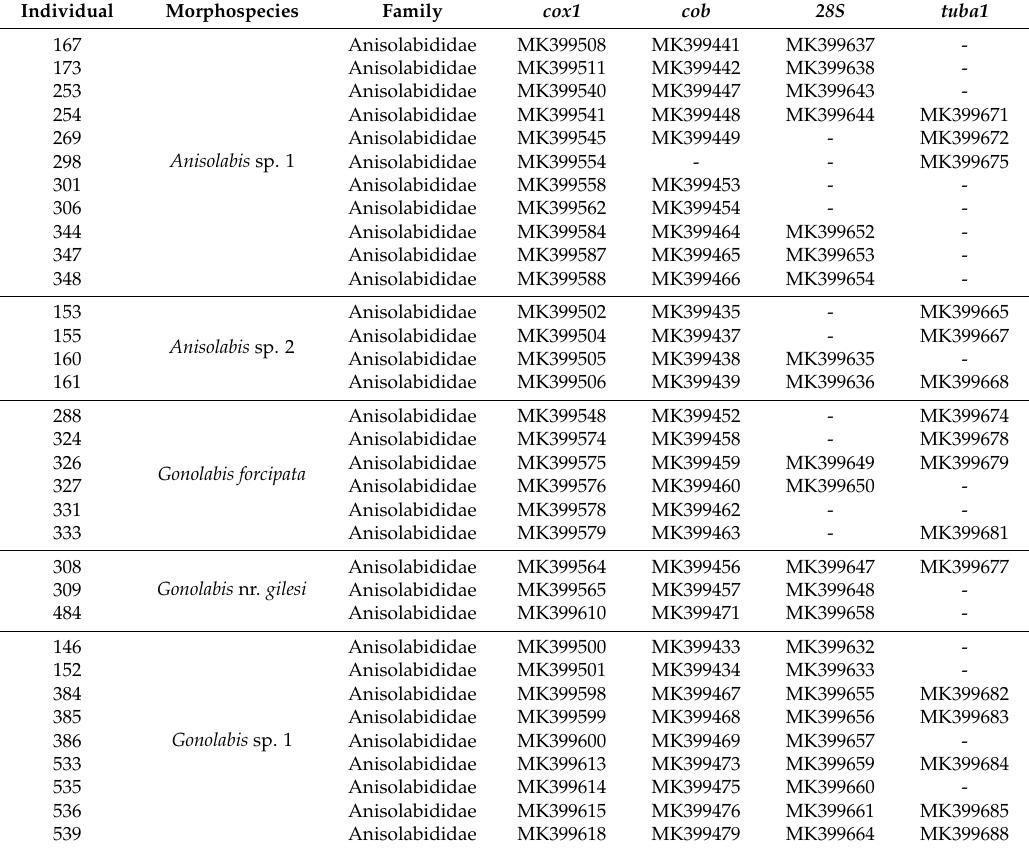
Table 4. Accession numbers of sequences generated by this study and those retrieved from GenBank for phylogenetic analysis. Dashes indicate missing data. ‘ cox1 ’ refers to a fragment of cytochrome c oxidase subunit 1 (658 bp). ‘ cob ’ refers to a fragment of cytochrome b (358 bp). ‘ 28S ’ refers to a fragment 28S ribosomal DNA (442 bp). ‘ tuba1 ’ refers to a fragment of the tubulin alpha-1 gene (466 bp). ‘Individual’ refers to a single adult Anisolabididae specimen’s in-house code number and is provided for reference to Figures